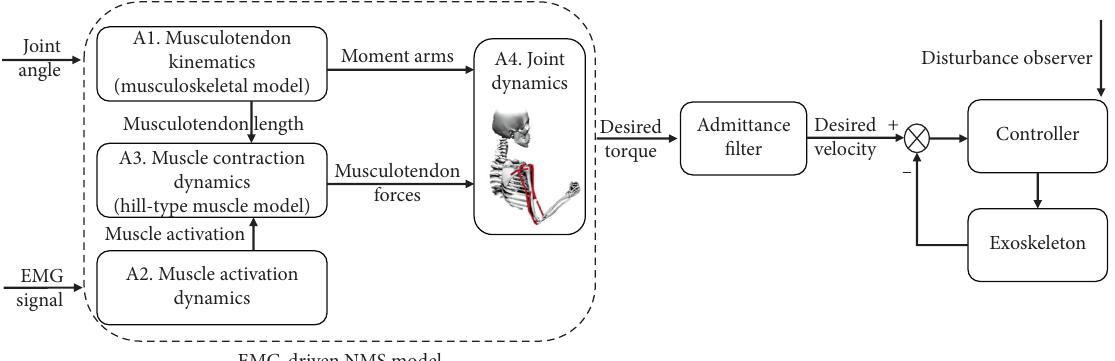
Figure 1: Schematic structure of the controller framework based on an EMG-driven NMS model. The NMS model consists of four components: (A1) the model’s musculotendon kinematics were used to compute musculotendon lengths and moment arms; (A2) muscle activation dynamics were employed to calculate the level of muscle activation involved in the processed EMG signals; (A3) muscle contraction dynamics according to a Hill-type muscle model were applied to predict musculotendon force, using calculated musculotendon length and muscle activation as inputs; (A4) joint dynamics was used to compute joint torques, using the calculated musculotendon forces and moment arms as inputs. The EMG signals and joint angles from the user were used to estimate the motion intention (desired torque) through the EMG-driven NMS model. Then, the desired torque was transmitted to the desired velocity through an admittance filter. A disturbance-observer-based adaptive fuzzy controller was developed for the robot manipulator system with model